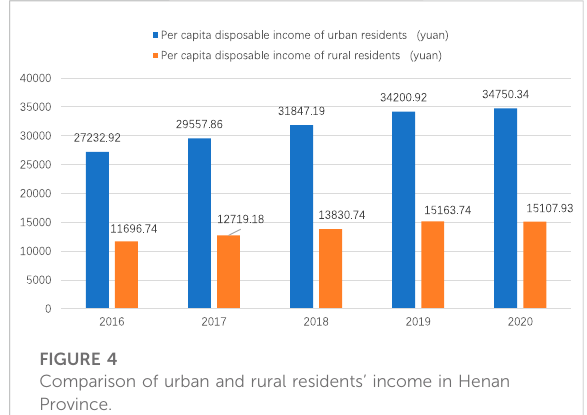
FIGURE 3 Urbanization rate of the permanent resident population in Henan Province from 2016 to 2020.